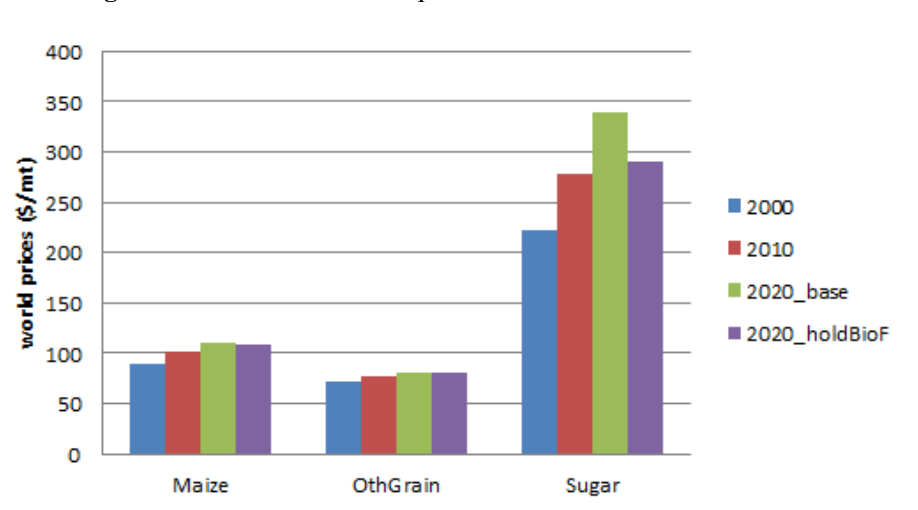
Figure 11. Ethanol feedstock prices under baseline and